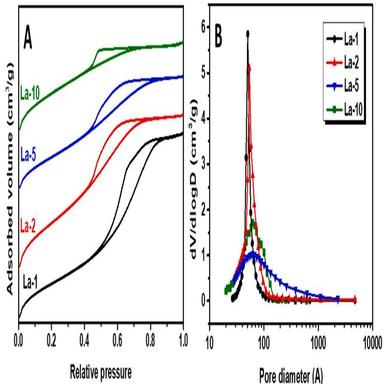
A- The adsorption/desorption isotherms of the prepared La-TUD-1 samples, B- The corresponding pore size distribution.